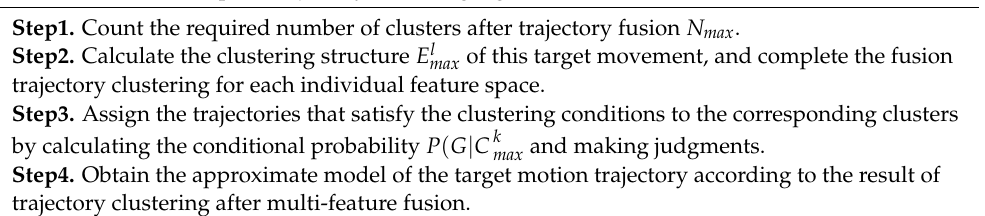
Algorithm 1. The steps of trajectory clustering algorithm based on multi-feature fusion.